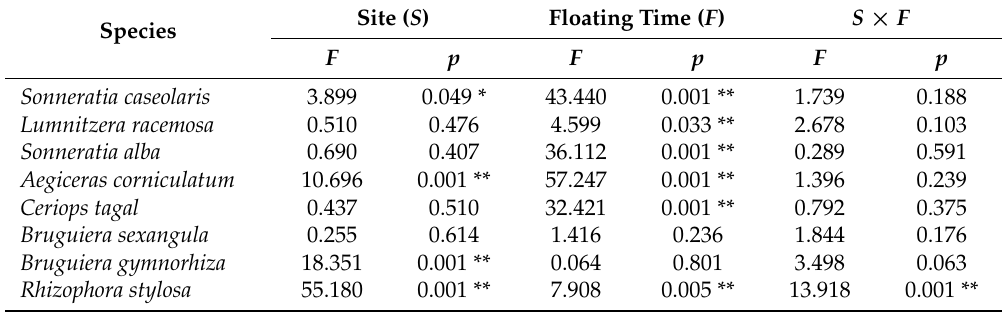
Table 2. Results of two-way ANOVA test ( p < 0.05) showing the effects of site and floating time on the propagule specific gravity of eight mangrove species along the Wenchang River, Hainan,